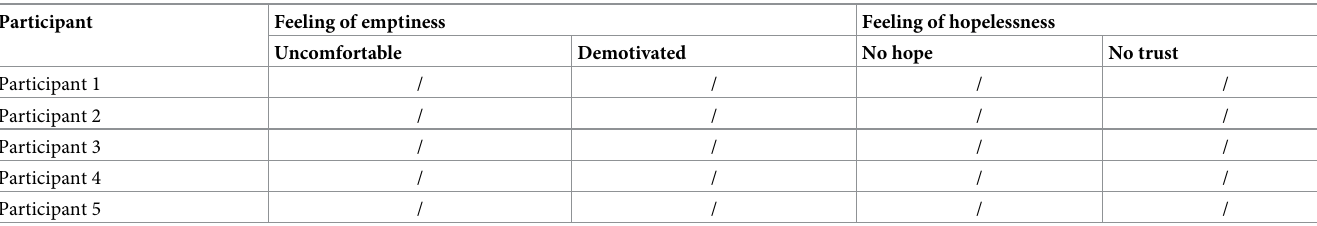
Table 4. Counselling experience among MSM living with